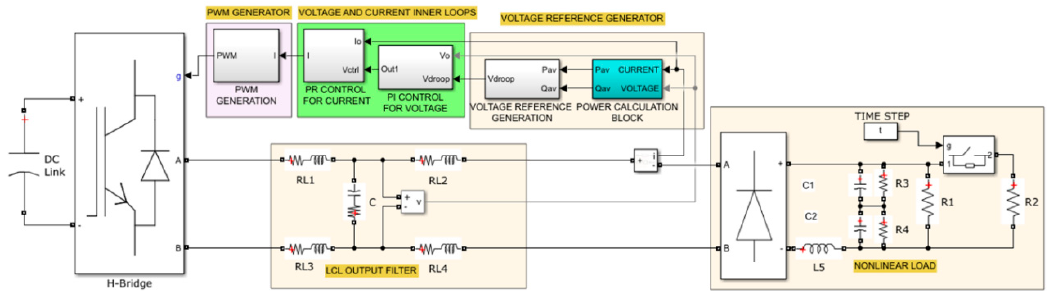
Figure 4. Scheme of the VSI experimental setup implemented at the iMG_AAU.